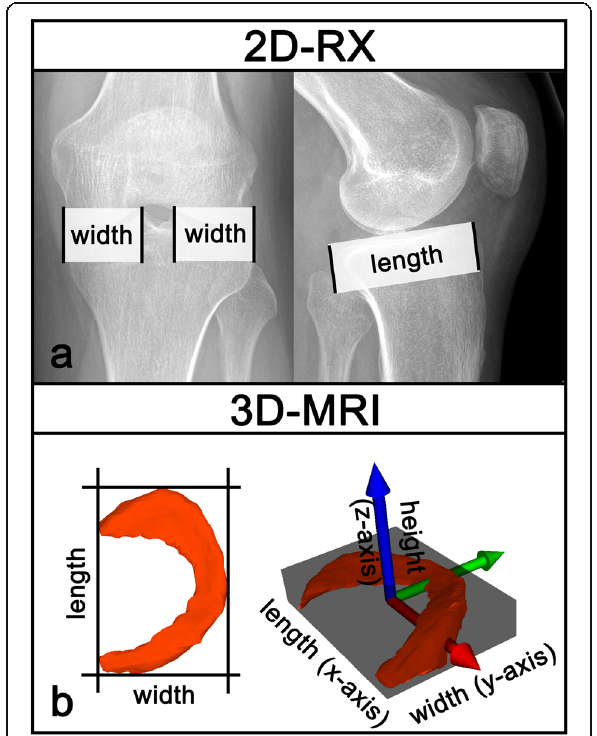
Fig. 2 Measurement meniscus dimensions in 2D-RX, 2D-MRI and 3D-MRI. a 2D-RX: Meniscus length = Distance between the anterior surface of the tibia above the tuberosity to the posterior margin of the tibial plateau, perpendicular to the joint line. Multiplication by 0.8 for medial and 0.7 for lateral meniscus. Meniscus width = Distance from the margin of the tibial metaphysis to the medial, respectively lateral tibial eminences, perpendicular to the joint line. b 3D-MRI: A best fitting three-dimensional box was placed around the meniscus. X-axis was parallel to a line between anterior and posterior meniscus root. X- axis = meniscus length, Y-axis = meniscus width, Z-axis = meniscus